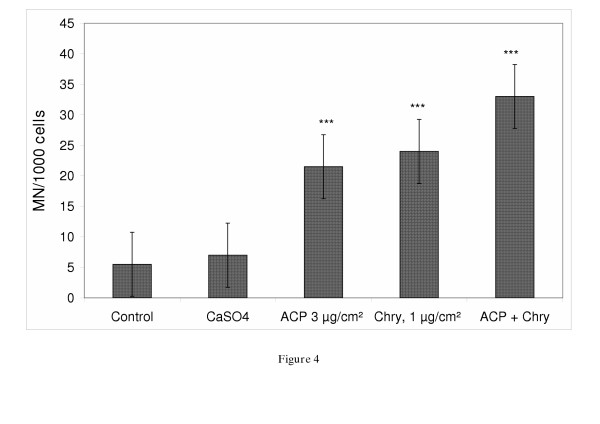
Micronucleus induction in V79-cells after co-exposure of asbestos and asbestos- cement (chrysotile: 1 μg/cm2, ACP: 3 μg/cm2; exposure time: 48 h). The experiment was repeated twice. Significance: *** p < 0.001.